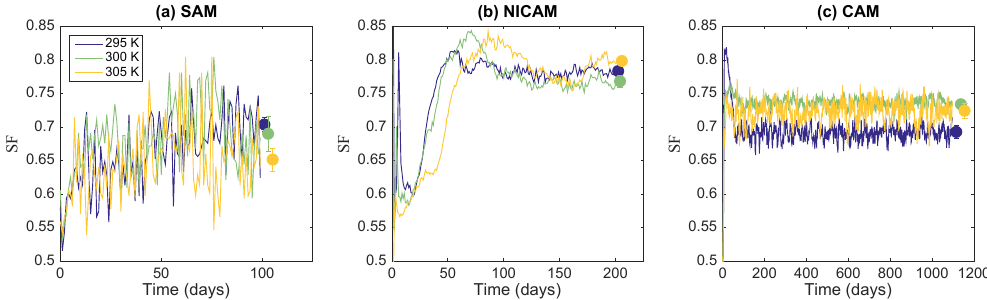
Figure 12. Subsidence fraction ( SF ) as a function of time in the (a) large-domain SAM simulations, (b) NICAM simulations and (c) CAM simulations. The circles indicate the mean subsidence fraction over the last 25 days of simulation; the error bars indicate the bounds of the 5–95% confidence interval. Note that the time axes are different in each panel. Also note that the NICAM simulations do not precisely follow the RCEMIP protocol, and the NICAM simulations labeled 295 and 305K are actually performed at surface temperatures of 296 and 304K,